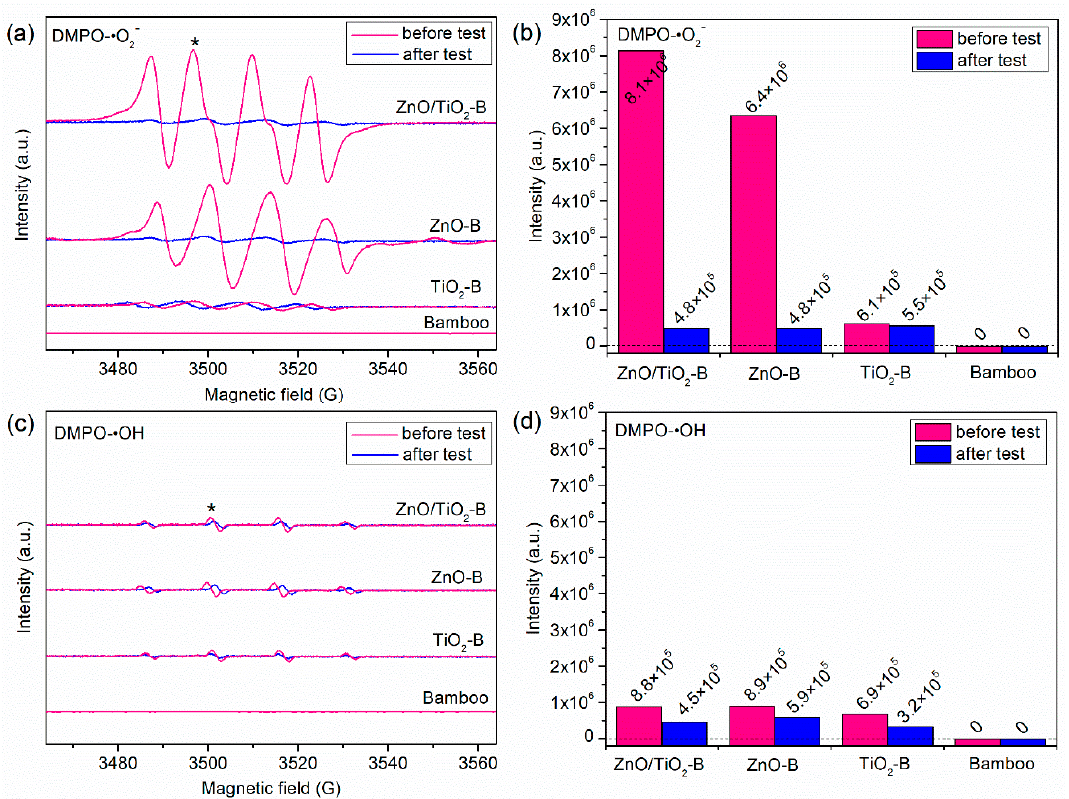
Figure 7. ( a ) The ESR spectra of DMPO- • O 2 − before and after the two-month test; ( b ) the intensity of the second peak (marked by the “*”) in the samples under visible light irradiation; ( c ) The ESR spectra of DMPO- • OH; and ( d ) the intensity of the second peak in the samples under visible light irradiation.